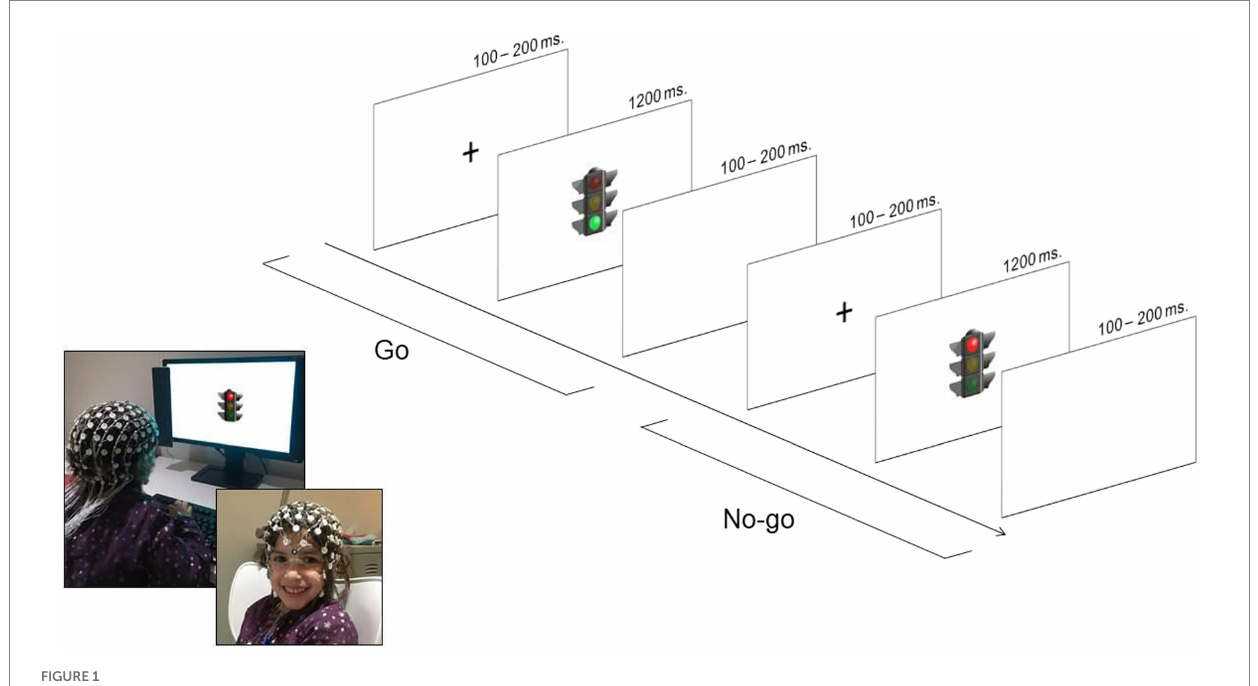
FIGURE 1 Go/No-go task